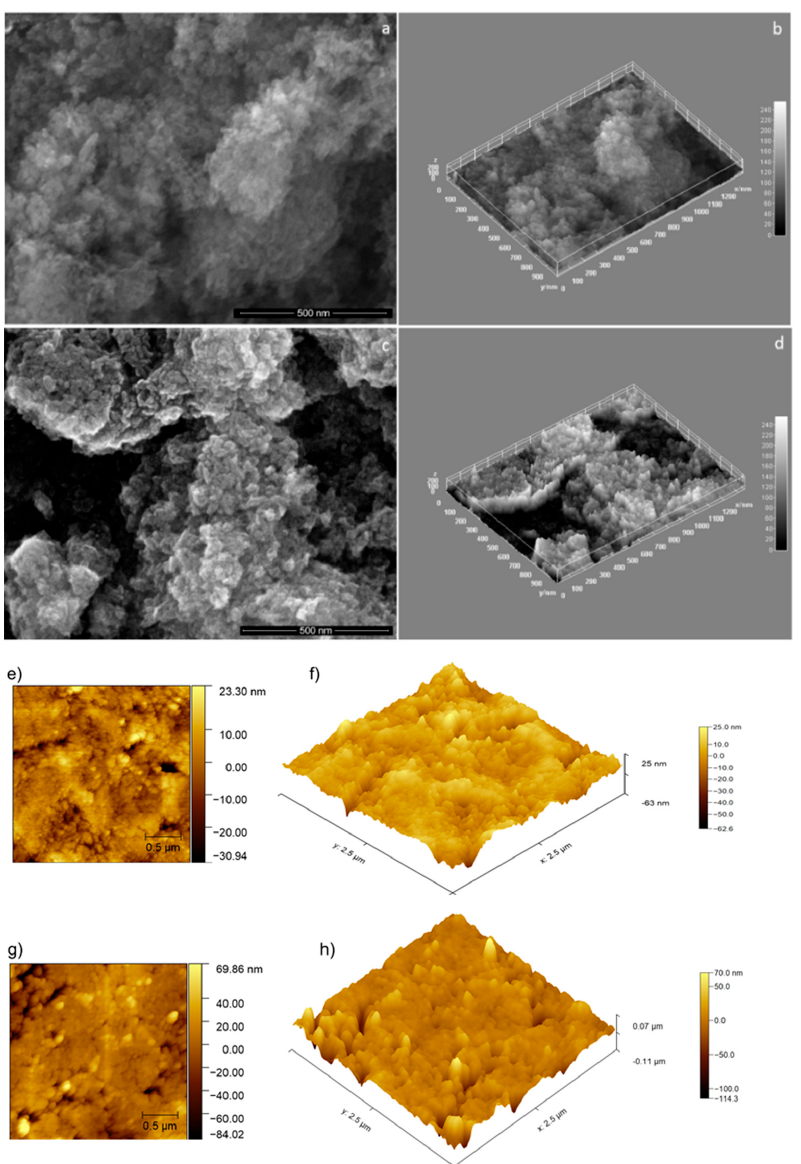
Figure 1. SEM images of HAp nanoparticles ( a ); 3D surface plot of SEM images of HAp ( b ); SEM images of HApWW sample ( c ); 3D surface plot of SEM images of HApWW sample ( d ) and AFM 2D and 3D surface topographies of HAp pellet ( e , f ) and HApWW pellet ( g , h ).